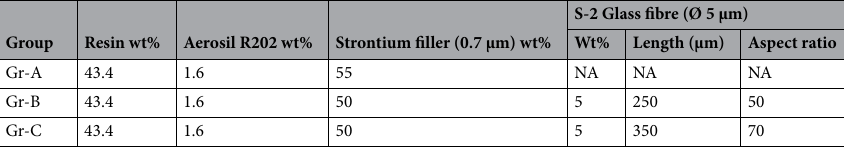
Table 2. Three groups of experimental composition.